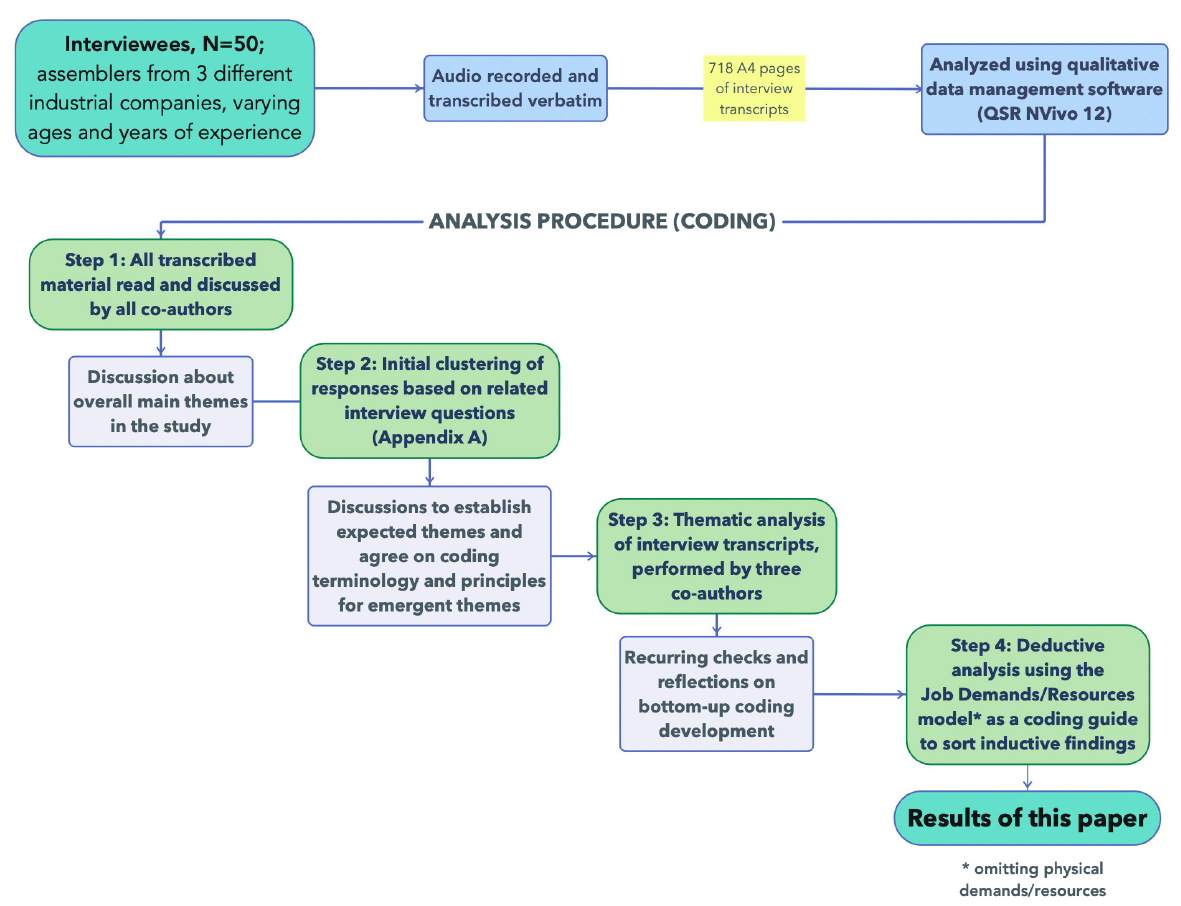
Figure 1. The data collection and analysis process.